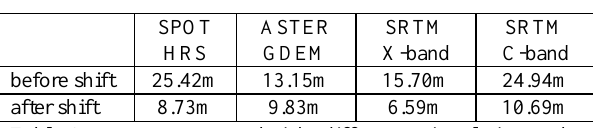
Table 2: root mean square height differences in relation to the REFZDAK before and after horizontal shift